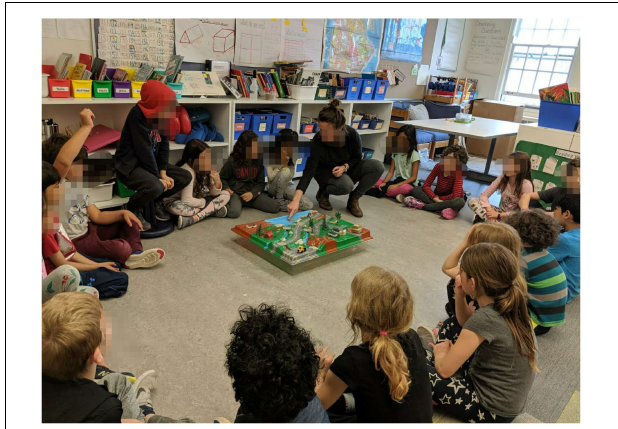
FIGURE 1 | An example of Knowledge Building talk.